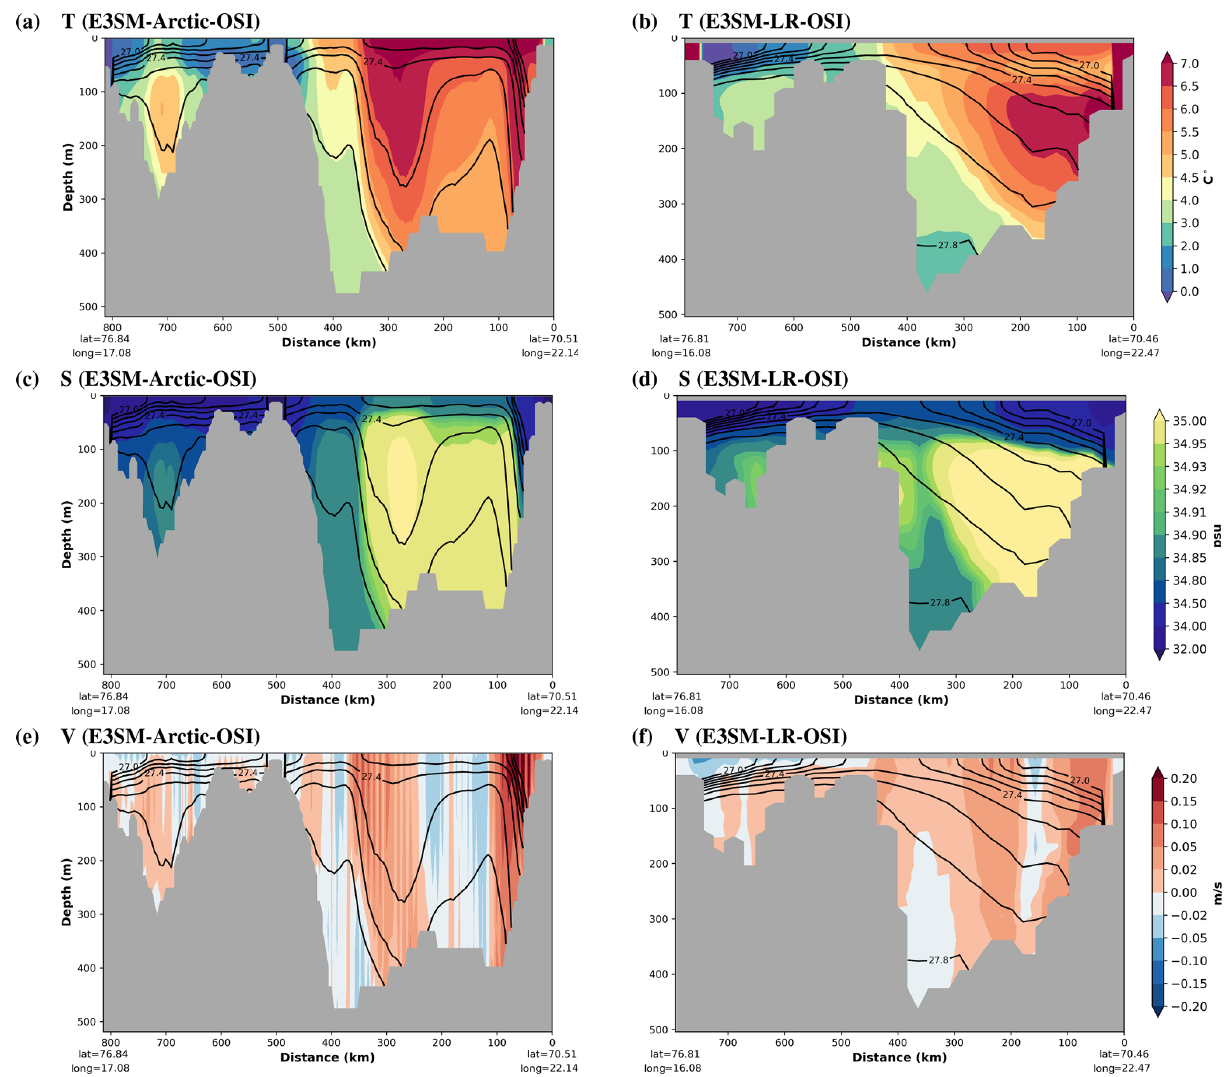
Figure 11. Similar to Fig. 10 but for the Barents Sea